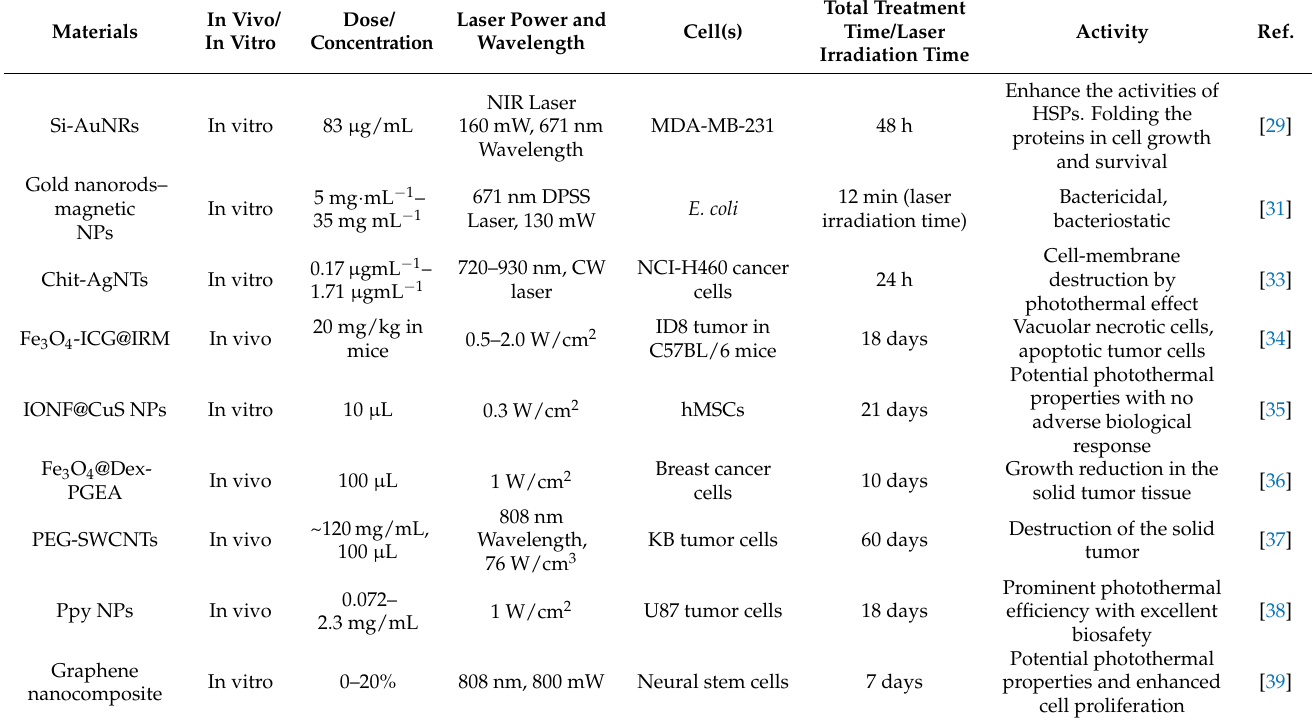
Table 1. Summary of NIR-light-responsive materials for photothermal cell